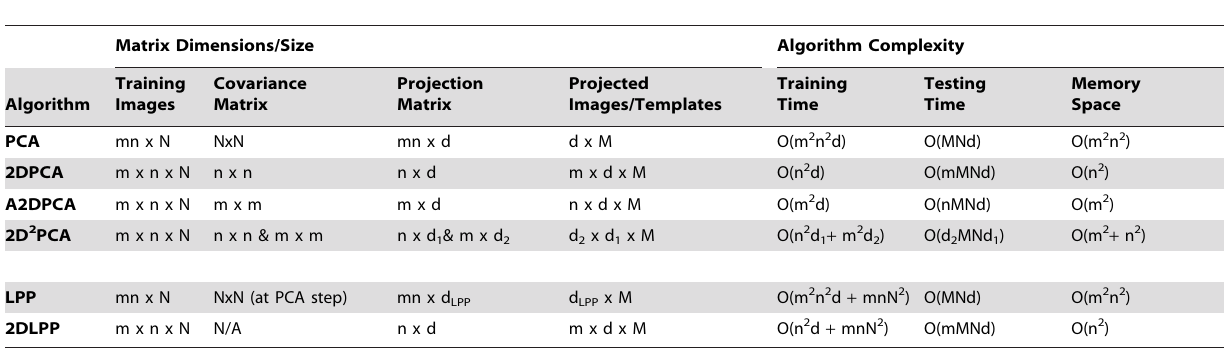
Table 1. Matrix Dimensions, Time/Computational Complexity and Space Complexity for Subspace Algorithms.